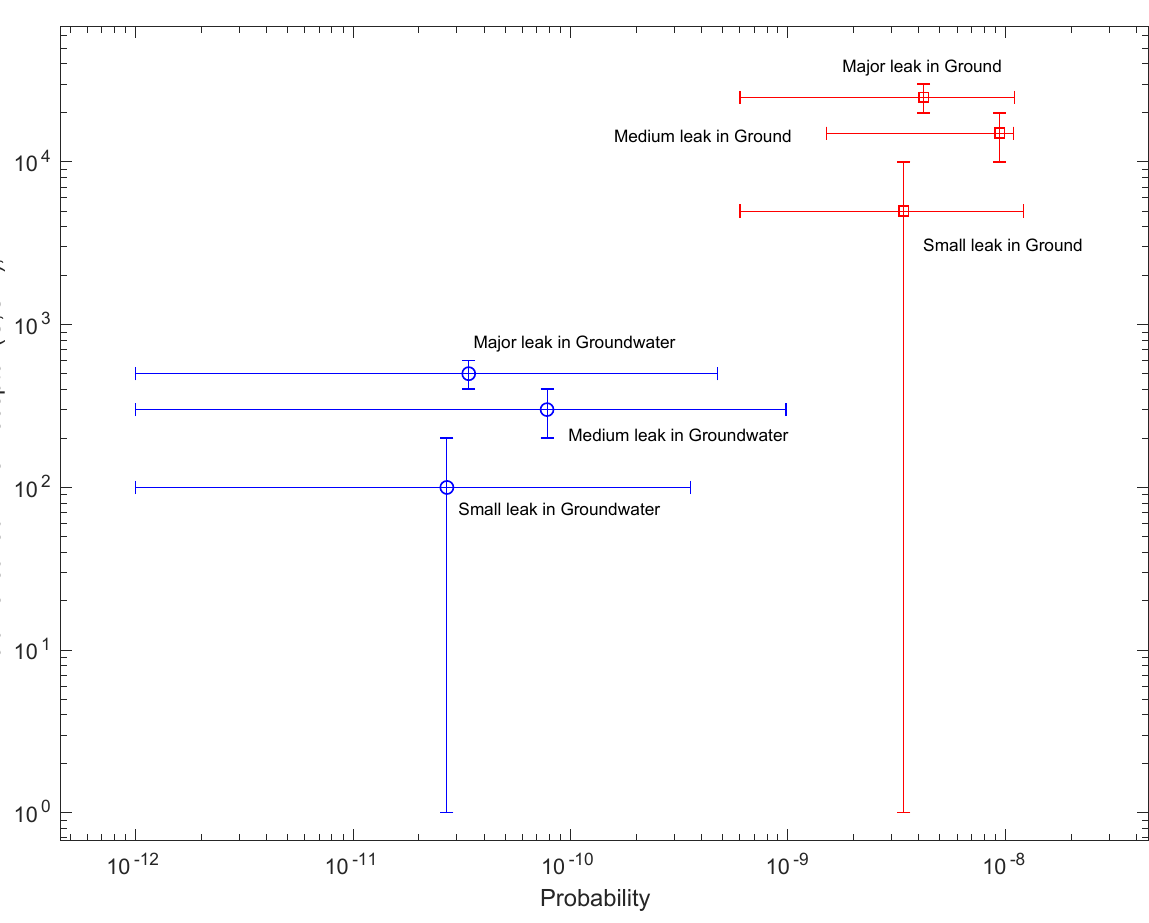
Figure 16. Risk matrix showing results of the MHR assessment showing scenarios of ground (red) and groundwater (blue) pollution associated with an oil leak in Phase 1.